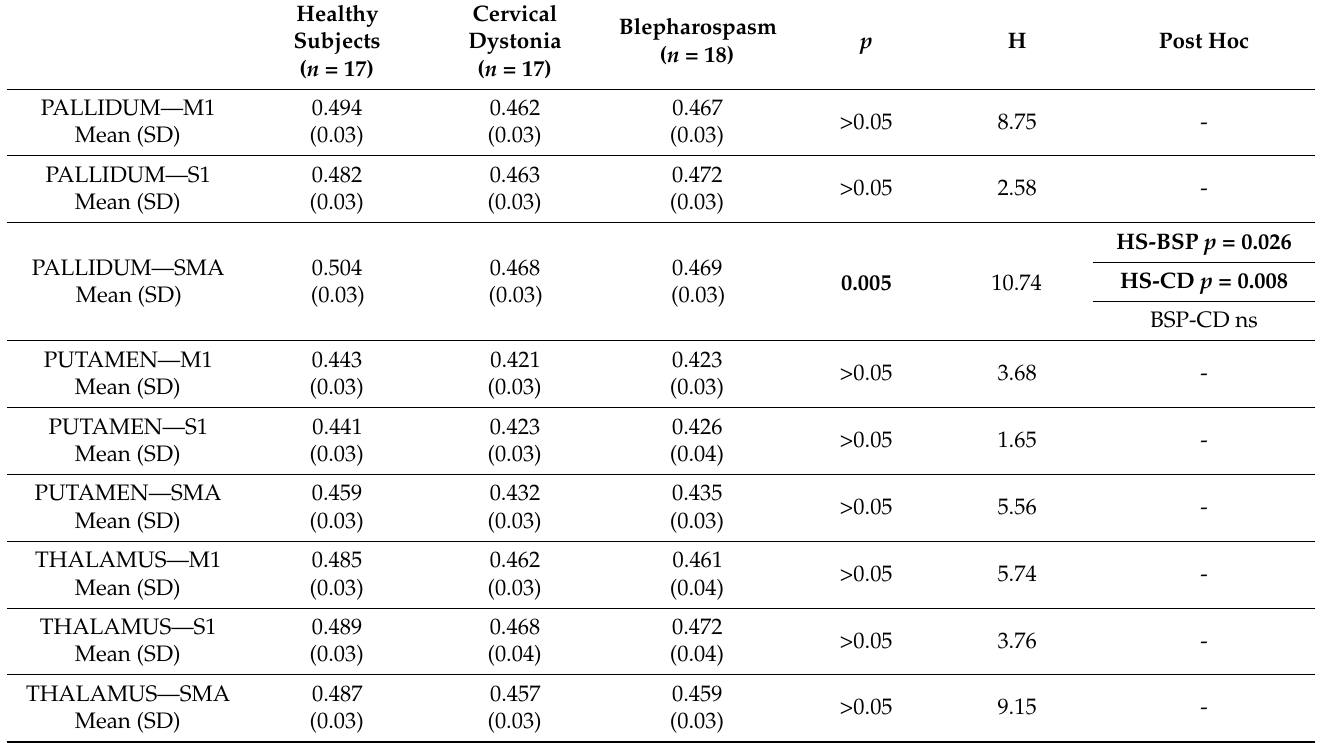
Table 2. Fractional anisotropy of subcortical-cortical WM tracts.